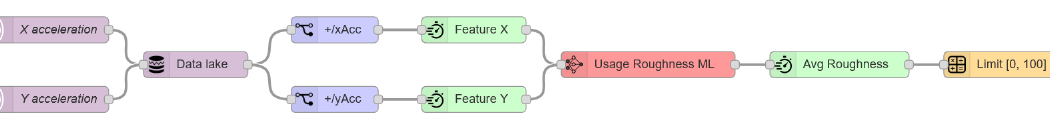
Figure 8. A screenshot sample of the development environment showing the flow nodes of the usage roughness application. The sensor attached to the hook of the crane sends X and Y acceleration data that are processed into an index between 0 and